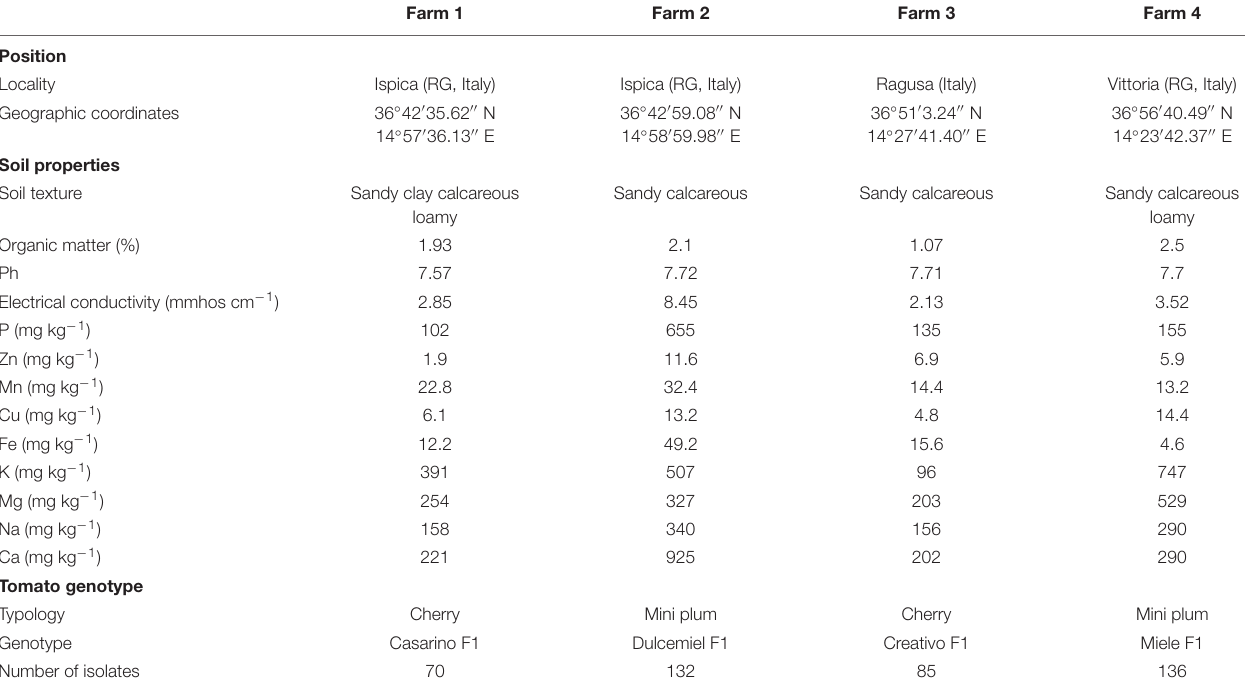
TABLE 1 | Data on sampling sites and number of bacterial isolates from the tomato root environment. Farm 1 Farm